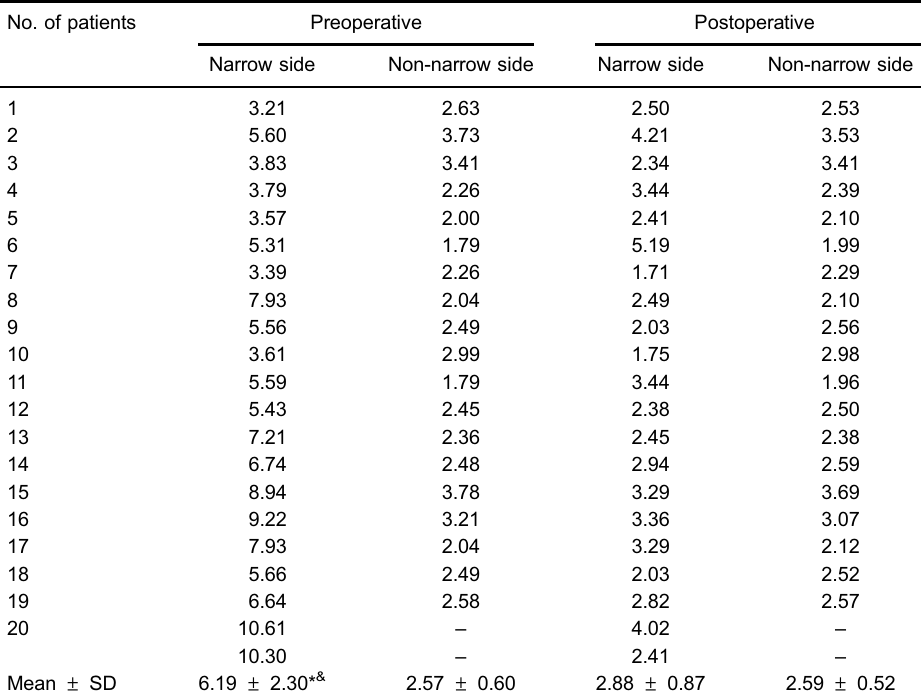
Table 4. Velocity in the cross-section of the nasal valve area in 20 patients (in m/s). No. of